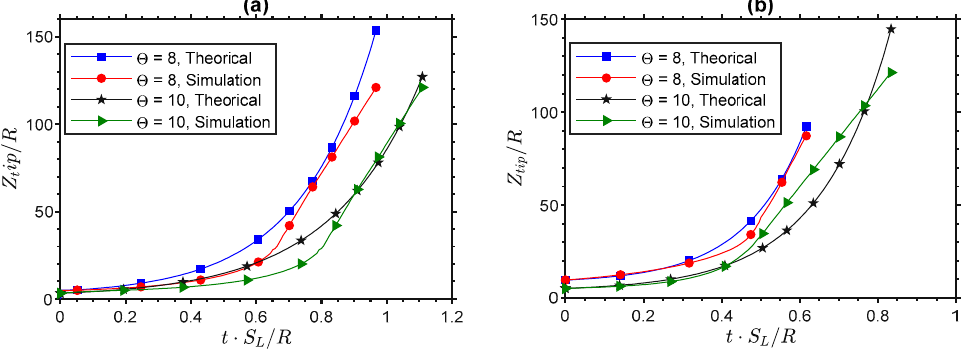
Figure 11. The scaled flame tip position Z tip / R versus the scaled time τ = tS L / R for burning in the channels of half-width R = 36 L f with the blockage ratios α = 1/2 ( a ) and α = 2/3 ( b ).